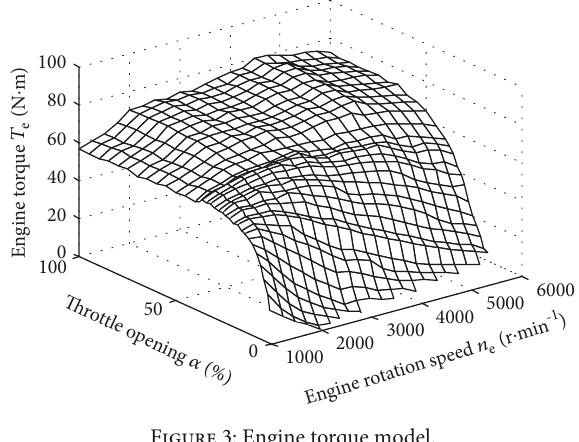
Figure 3: Engine torque model.